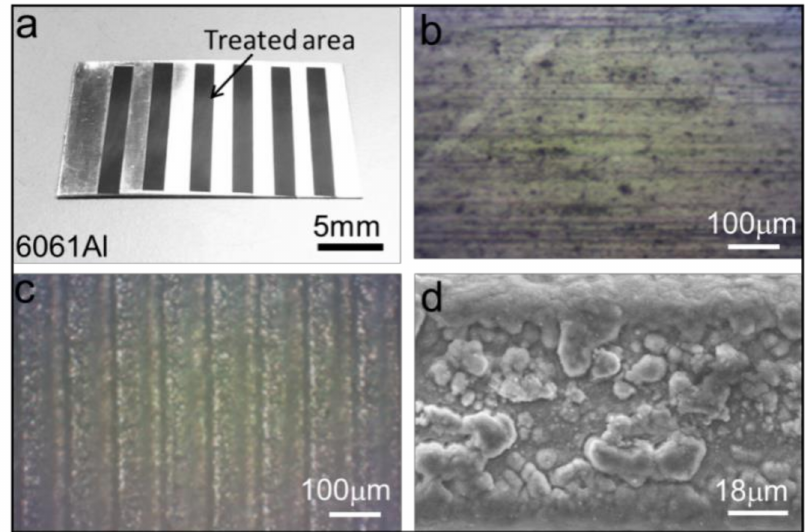
Figure 2. Surface topography of laser-ablated sample. ( a – c ) Optical image of original sample and laser-treated area on the 6061 alloy sheet. It can be seen that the microgroove arrays are regularly arranged in the treated area with a spacing of ~100 µ m. ( d ) SEMs of laser-induced microgrooves, it can be seen that there are some nanoparticles (200~500 nm) induced by debris deposition on the